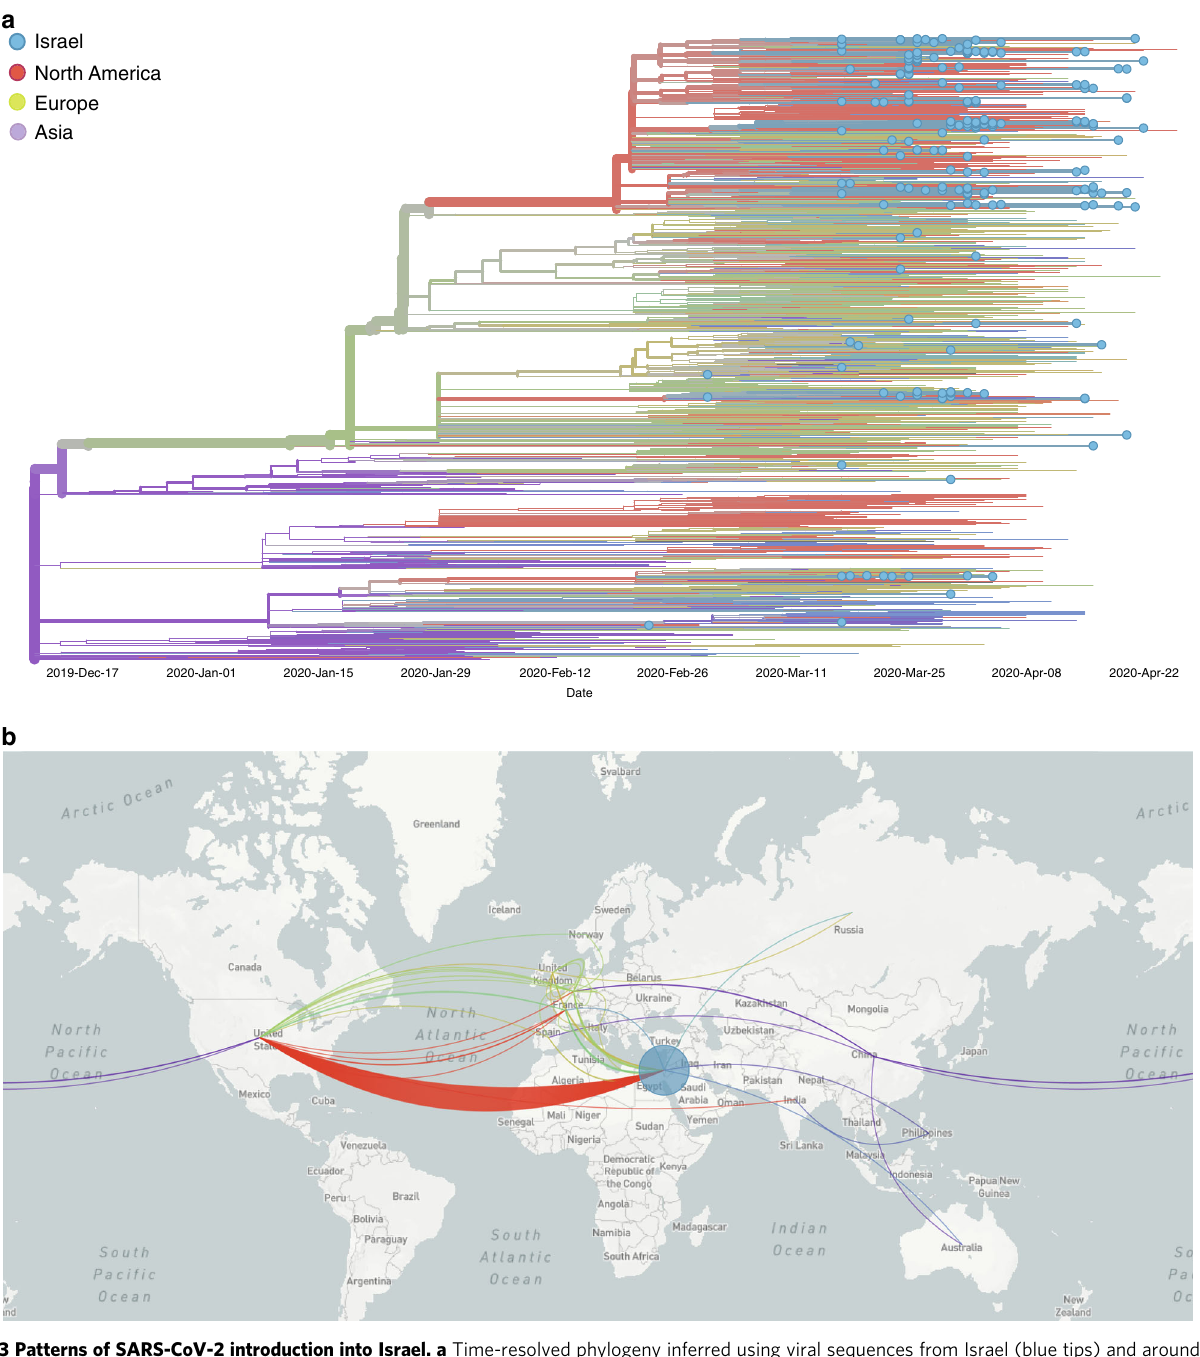
Fig. 3 Patterns of SARS-CoV-2 introduction into Israel. a Time-resolved phylogeny inferred using viral sequences from Israel (blue tips) and around the world (tips without dots). Lineages are colored by inferred region of circulation. Phylogeographic analysis reveals multiple introductions into Israel, mainly from the U.S. b Map of phylogenetically inferred introductions into Israel highlighting the dominance of the U.S. and to a lesser extent Europe as the geographic sources of SARS-CoV-2 introductions into Israel. Figure (including map) generated using NextStrain 32 . Source data are provided as a Source Data fi